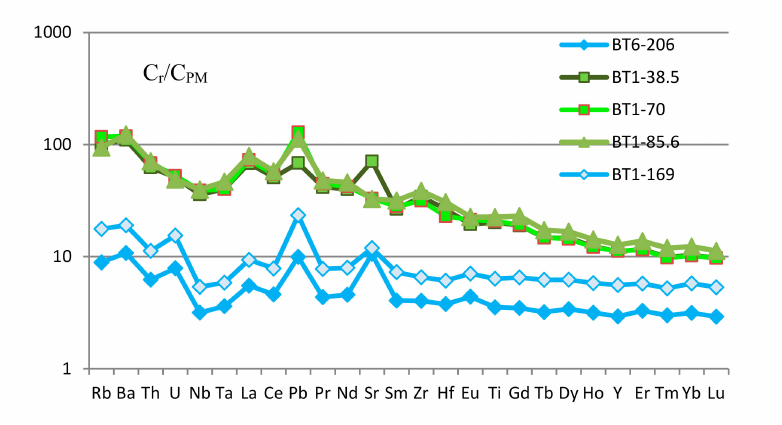
Figure 8. Spidergram for normalized [19] trace-element patterns of the rocks from the alleged Ergalakh (green lines) and Norilsk intrusions (blue lines) of the Turumakit area (data in Table S1).